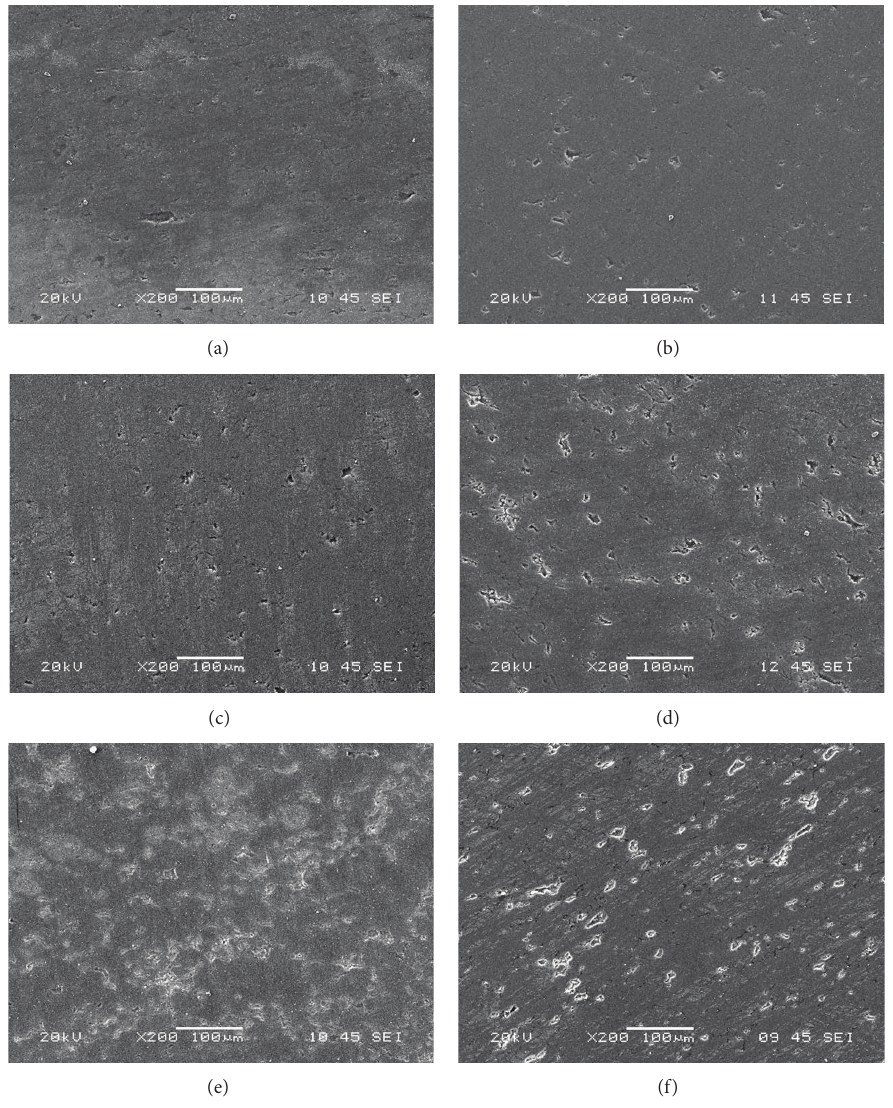
Figure 6: SEM micrographs of Al2124 + 1wt.% CNTs spark plasma sintered at (a) 400 ∘ C, (b) 450 ∘ C, and (c) 500 ∘ C and Al2124 + 2 wt.% CNTs spark plasma sintered at (d) 400 ∘ C, (e) 450 ∘ C, and (f) 500 ∘